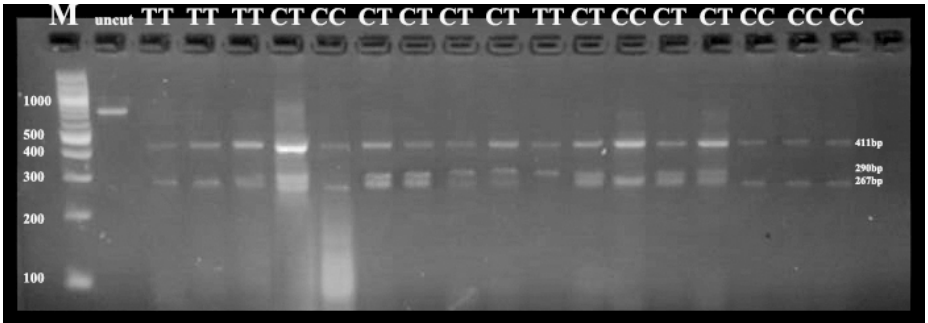
Figure 1. Agarose gel electrophoresis (3%) showing PCR RFLP of exon 2 of MTNR1A using the RsaI enzyme. M: 100bp DNA ladder; uncut, 824bp. Lanes represent the genotypes CC (411, 267bp), TT (411, 290bp) and CT (411, 290,